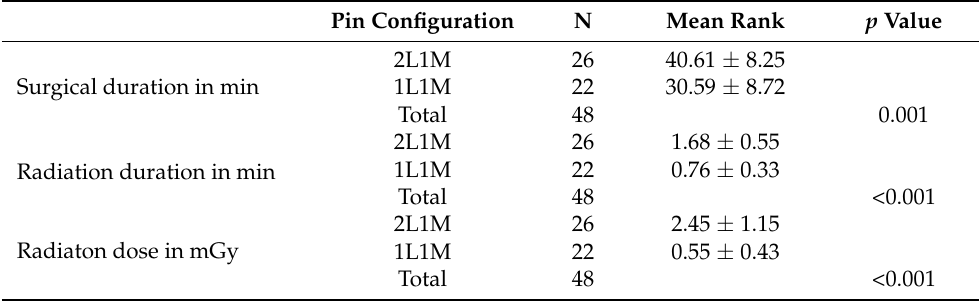
Table 2. Comparison of surgical time, radiation dose, and duration between pin